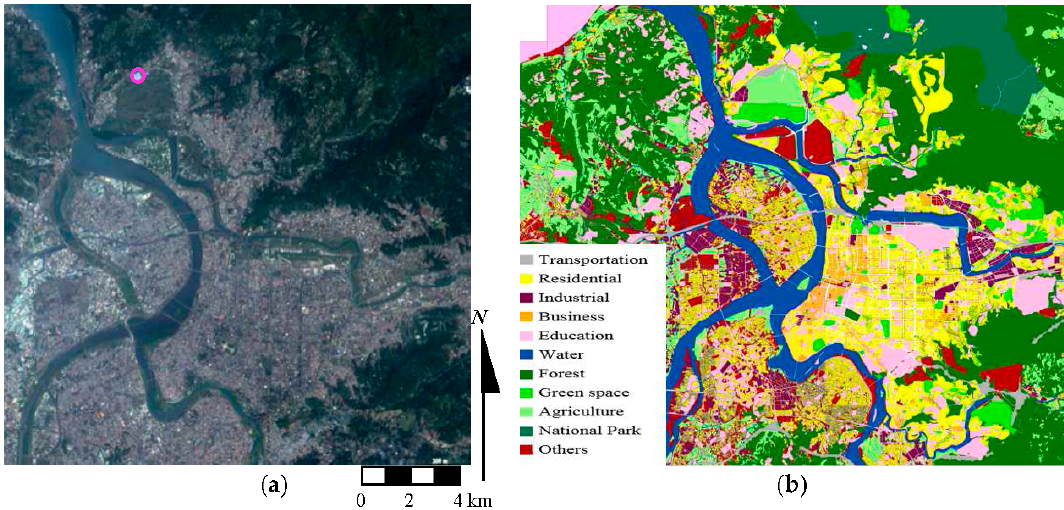
Figure 2. ( a ) True-color Advanced Land Observing Satellite (ALOS) image of the study area; and ( b ) land-use map for the year 2009 (Ministry of Interior, Taiwan). The purple-circled area, the Beitou Depot of the Taipei mass rapid transit (MRT), is identified as unclassified by the chi-square threshold technique (see details in Section 4.2.3). The coordinates of the lower-left corner of panel ( a ) are 121°25 ′ 50 ″ E, 24°59 ′ 12 ″ N.